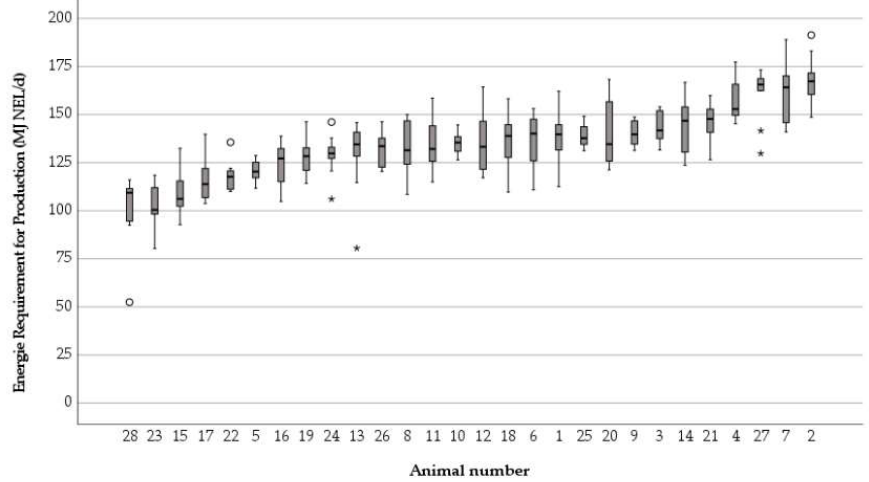
Figure 6. Energy requirement for production (MJ NEL/d) calculated between weeks 2 and 15 post- partum (p.p.). In each subfigure, the boxplots respectively highlight the median, upper, and lower quartiles of each week. Box whiskers extended to the most extreme nonoutlier data points were considered as outliers if they lay more than 1.5 times the interquartile range from the edge of the box. Small circles = outliers (1.5 × interquartile range (IQR)); asterisks = extreme values (3 × IQR). Total energy requirement (TER) had a mean of 172.6 MJ NEL/d and decreased in the